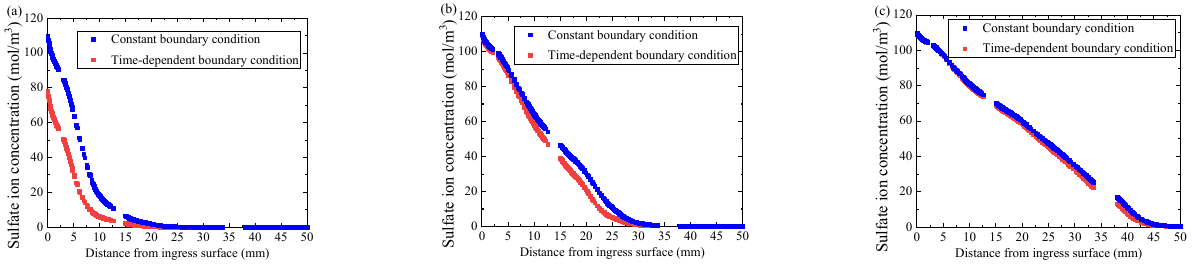
Figure 17. Sulfate ion concentration distribution in the pore solution on different ingress time. ( a ) 180th day, ( b ) 720th day, and ( c ) 1800th day, respectively.